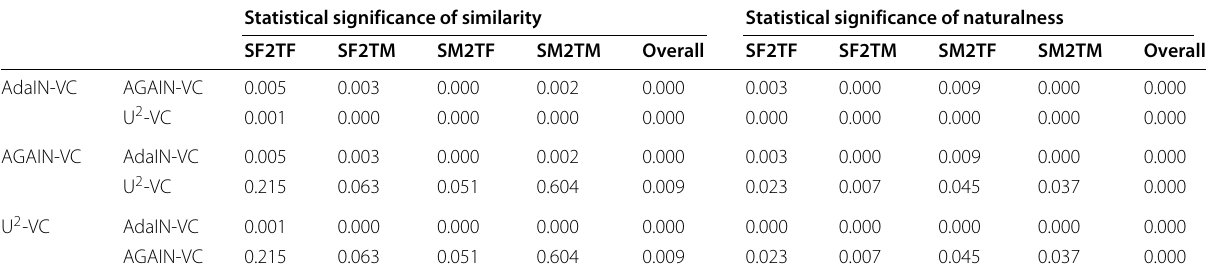
Table 11 Statistical significance of the MOS results of mono-lingual conversion in unseen-to-unseen scenario. “Overall” represents the overall statistical analysis of all the four conversion cases